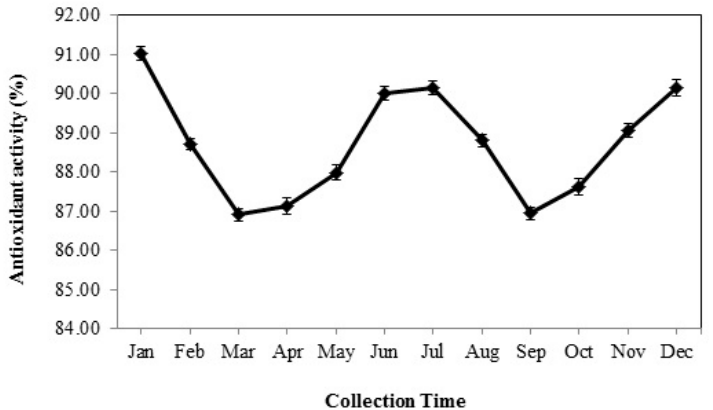
Figure 4. The seasonal variation of antioxidant activity of Arabian lilac. Values are the mean ± SD of three replications ( n = 3).